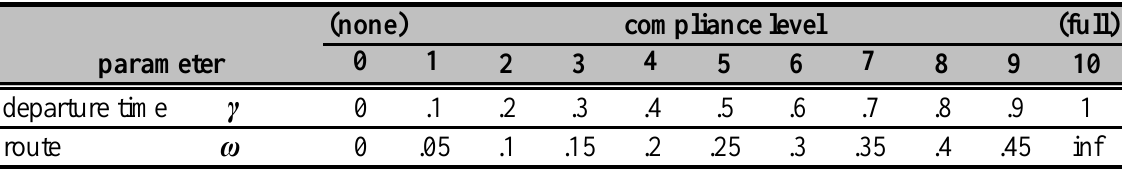
Figure 5. Instructed evacuation routes, P Table 1. Parameter settings relating to traveller compliance behaviour corresponding to compliance levels which are tested for